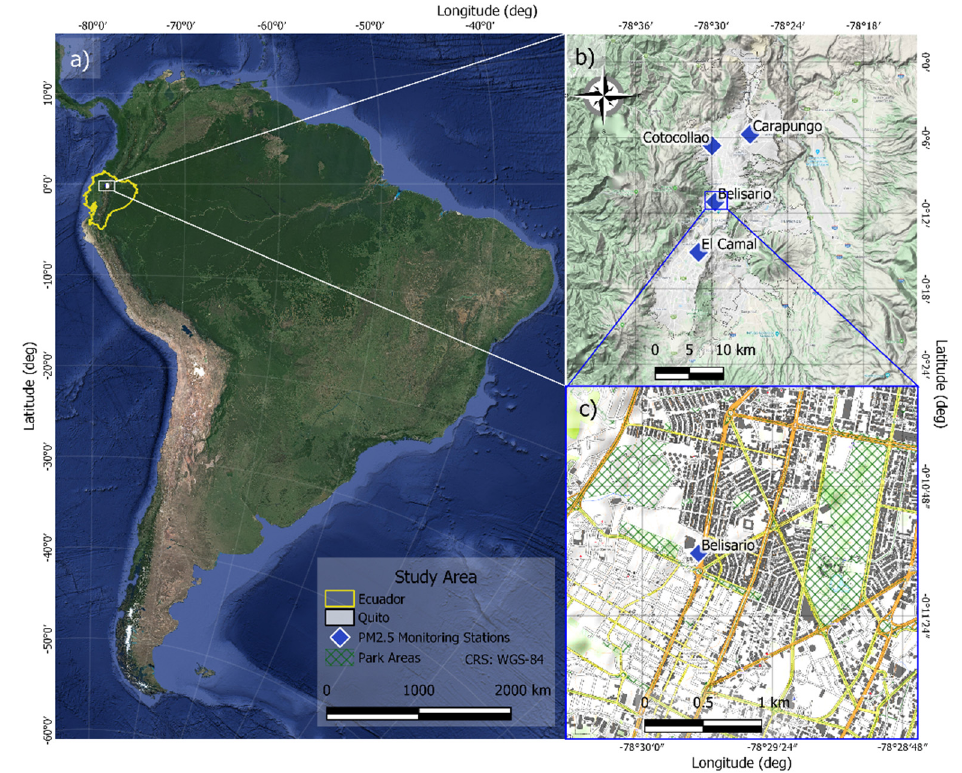
Figure 1. Location of the study area in the center of Quito, Ecuador ( a ). The upper right panel ( b ) indicates the locations of the air quality network stations, and the lower right panel ( c ) shows the study area in the urban infrastructure.